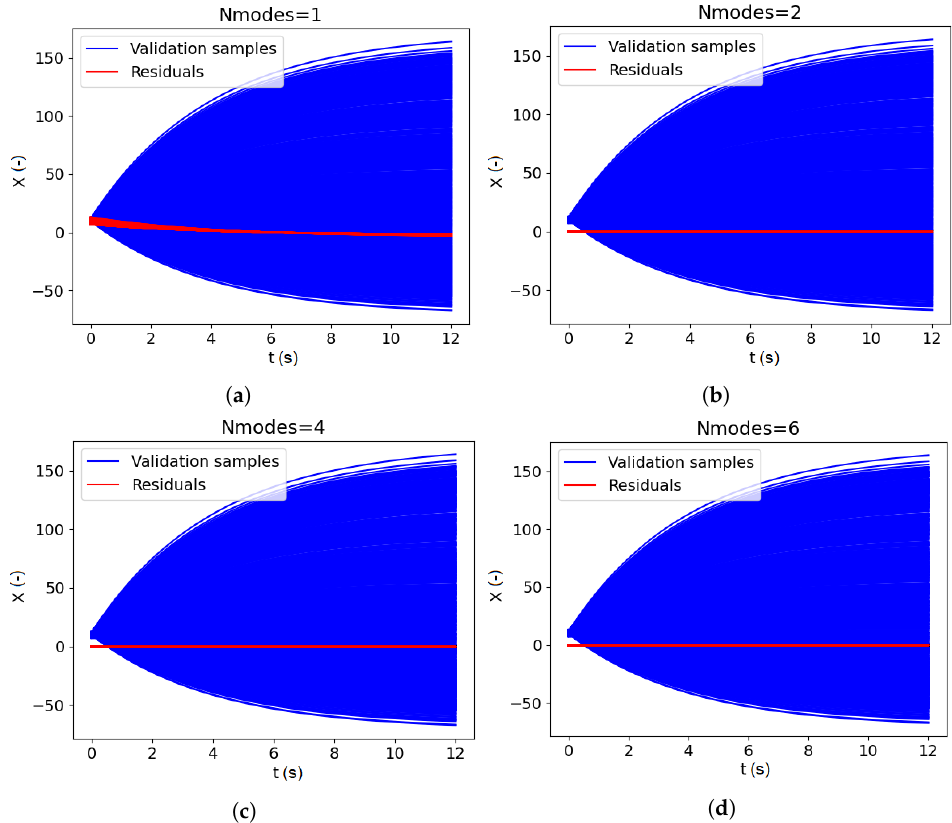
Figure 6. Karhunen–Loève validation with respect to the number of modes: 1 ( a ), 2 ( b ), 4 ( c ), 6 ( d ).